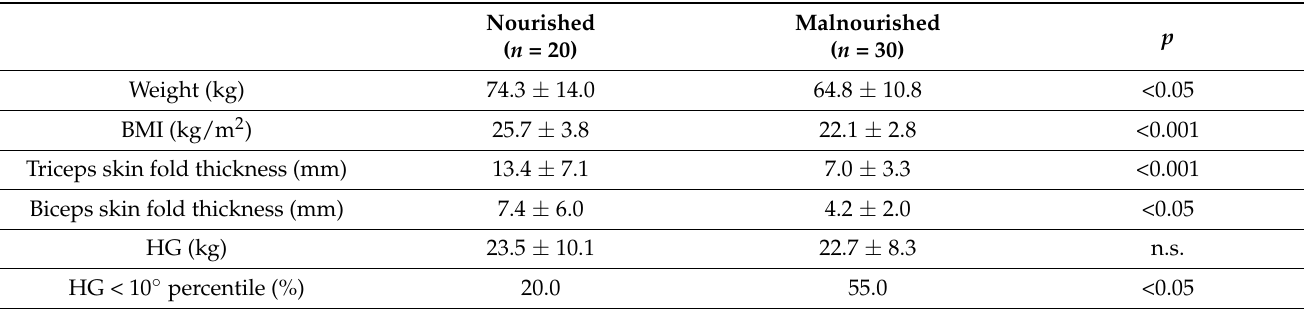
Table 2. Anthropometric data and muscle function of cirrhotic patients divided by nutritional status (malnutrition defined for MAMC < 5 ◦ percentile).